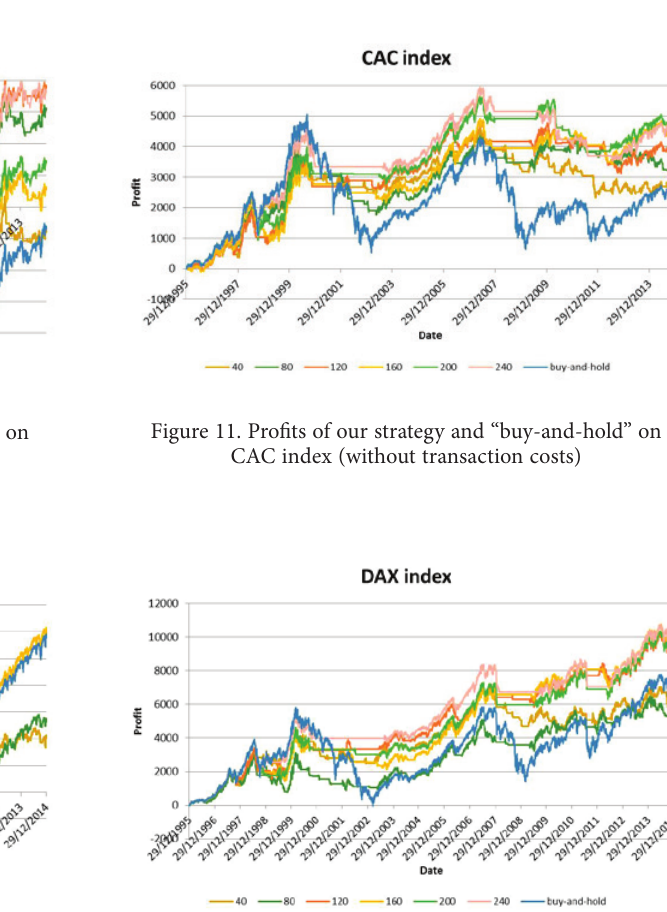
Figure 12. Profits of our strategy and “buy-and-hold” on DAX index (without transaction